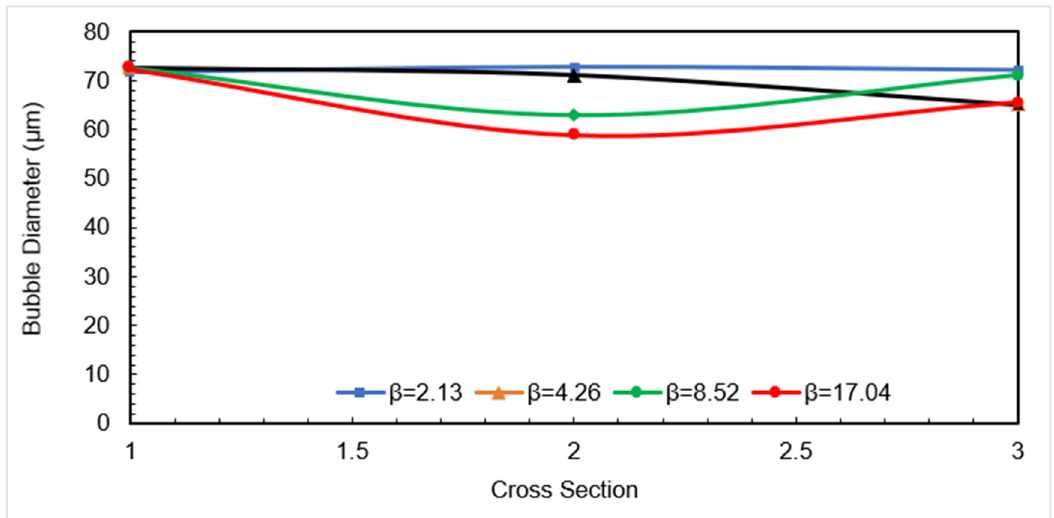
Figure 15. Effect of diverging angle on evolution of average bubble diameter at different axial locations (cross sections 1, 2, and 3 are the diffuser entry, midpoint, and end, respectively). (Water flow rate = 8.21 L/min, air flow rate = 0.1 L/min).